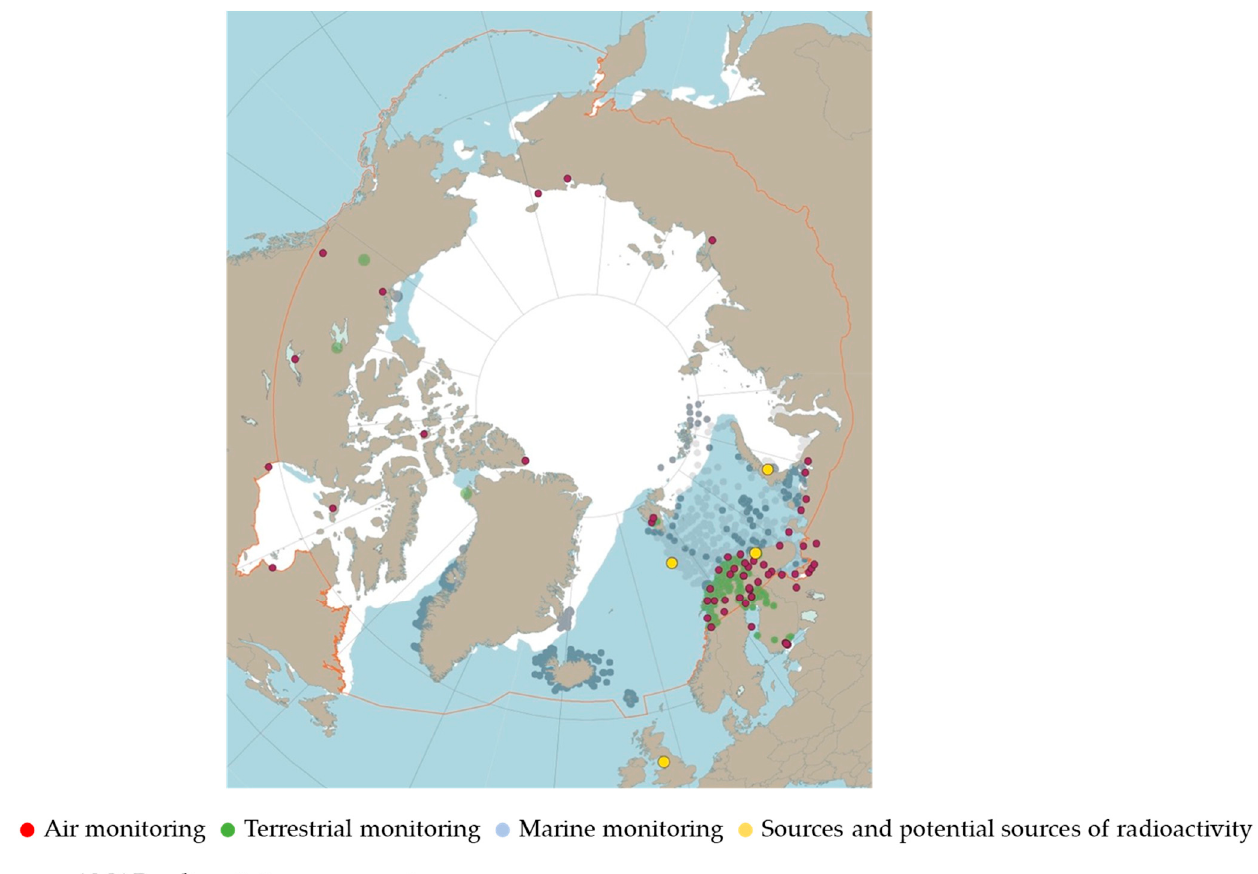
Figure 4. Monitoring results and sources and potential sources of radioactivity discussed in AMAP assessment 2015 [32].